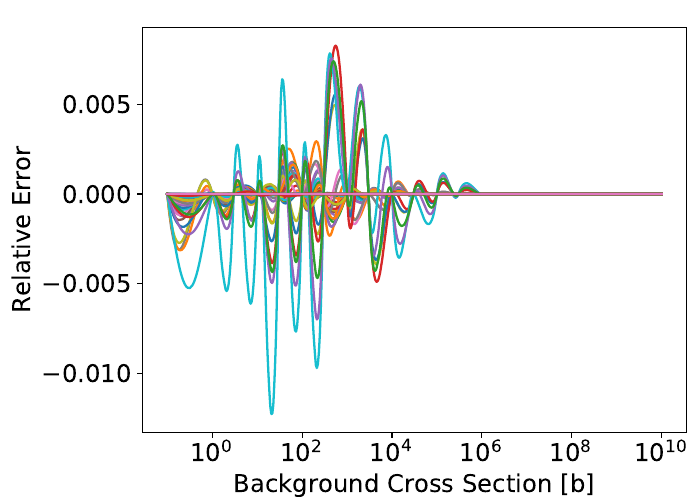
Figure 3: Relative error of interpolated cross sections for each resonant energy group of U-238 in the XMAS 172-group structure using the 15-point dilution grid and the proposed spline-based interpolation